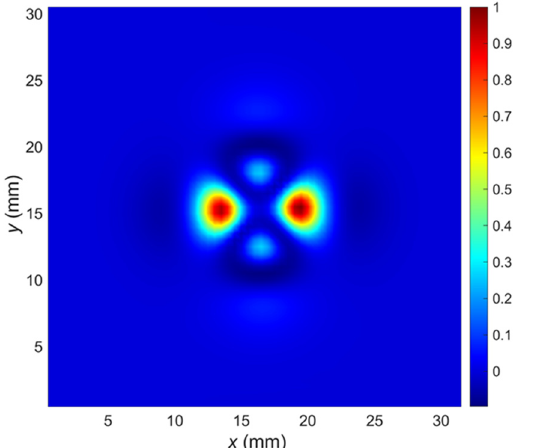
Figure 7. An example of the C-scan (2D plot of the values vs. sensor coordinates, excitation fre- quency f = 1995 Hz).